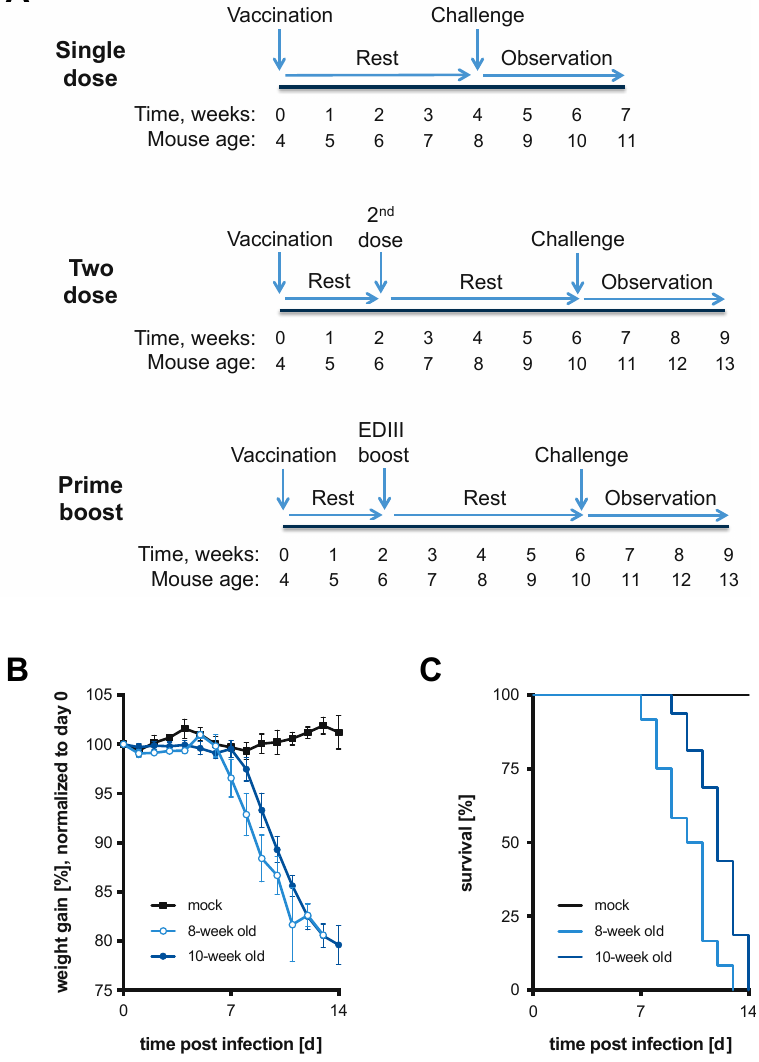
Figure 1. Vaccinations schemes and murine model of Powassan virus disease. ( A ) Depiction of vaccination schemes that were used to test vaccine efficacy. Four-week-old BL6 mice were vaccinated and (i) challenged with a lethal dose of DTV four weeks later (Single dose). In two additional vaccination regimens, two weeks after the first vaccination mice received (ii) a second live-attenuated virus vaccination (Two dose) or (iii) a protein boost with DTV EDIII (Prime boost), followed by DTV challenge four weeks later. Upon challenge, mice were observed for weight loss and disease signs for up to three weeks. ( B ) Mice infected with 2.5 × 10 4 PFU of DTV via the s.c. route were monitored daily for weight loss and disease signs and sacrificed upon meeting humane endpoints. The average normalized weight of infected eight-week-old ( n = 12) and 10-week-old ( n = 16) mice is plotted. Weights were normalized to the day of inoculation (day 0). Error bars indicate standard deviation (SD). ( C ) Survival curves of mice challenged with DTV in ( B ) are plotted. RNA was isolated from TRIzol-inactivated tissues and serum by chloroform extraction, ethanol precipitation, and purification using an RNeasy kit (Qiagen, cat.